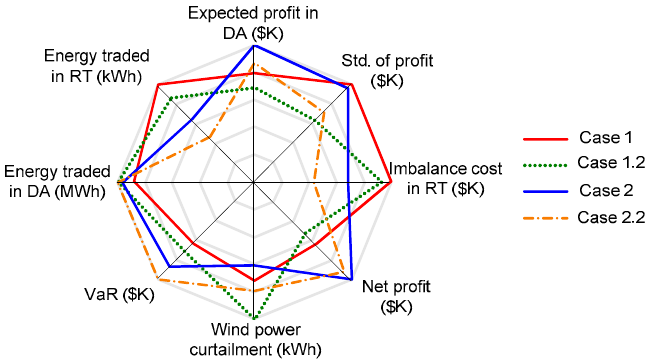
Figure 8. Performance evaluation of different cases.